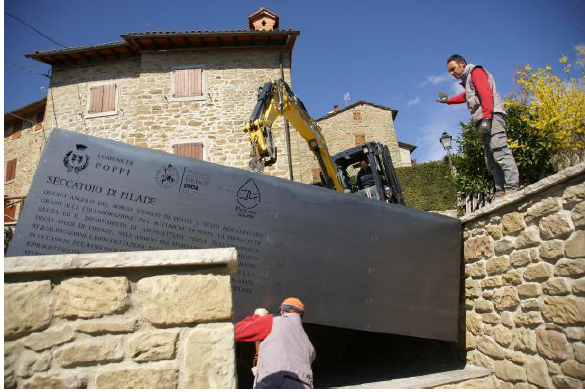
Figure 12. The monobloc of the COR-TEN ladder during the installation operations.